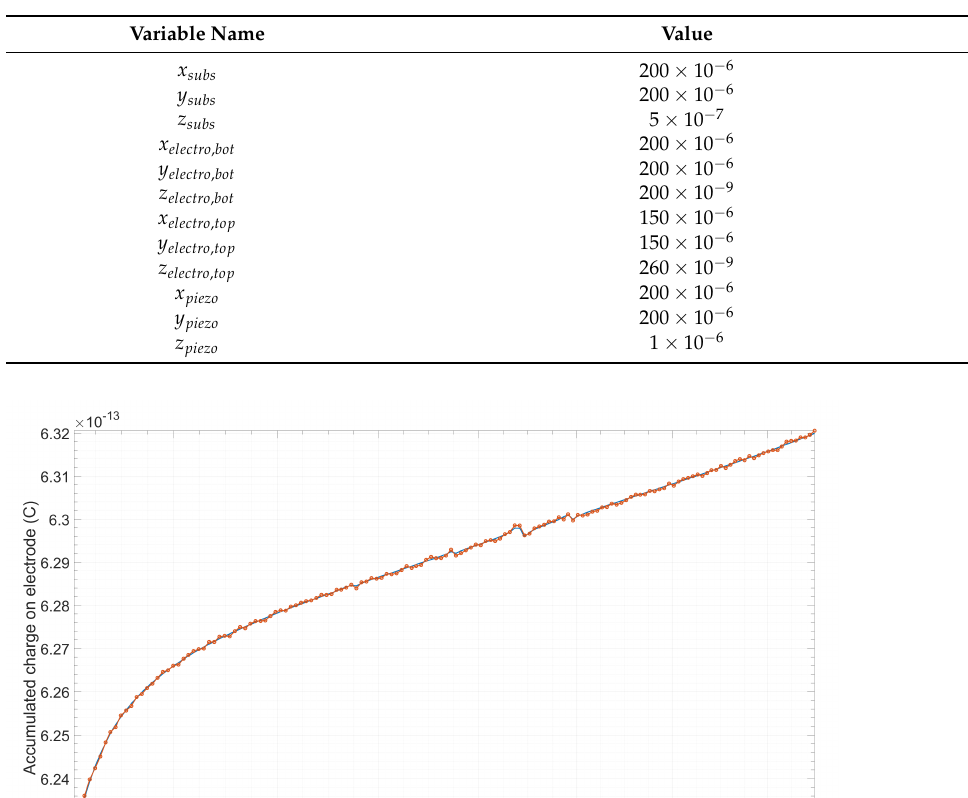
Table 10. Variable definition.